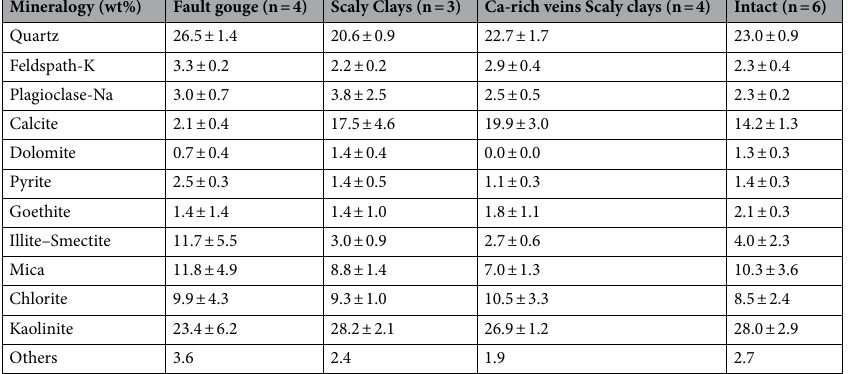
Table 1. Bulk (% weight) mineralogical composition of Opalinus Clay samples. We present results as X ± S, where X is the mean and S the standard deviation; “n” corresponds to the number of